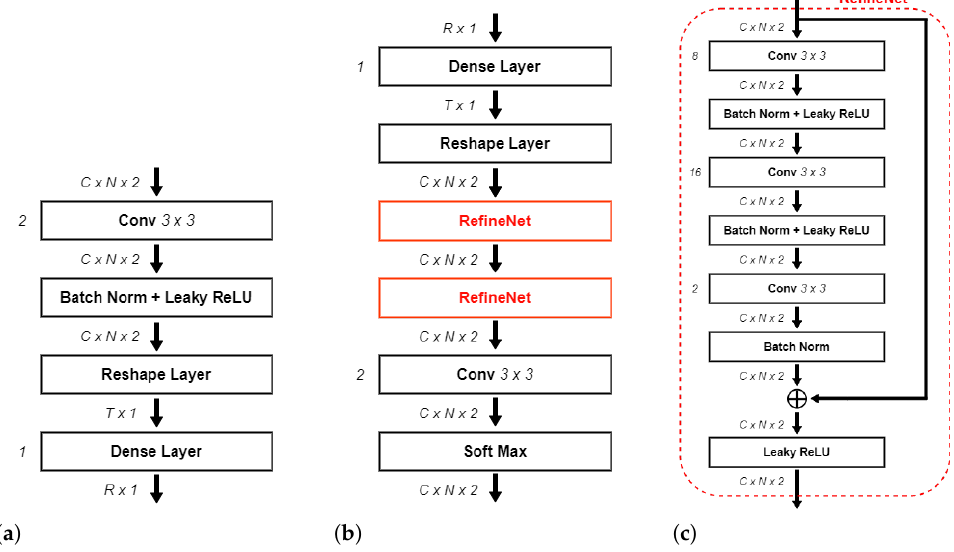
Figure 5. NR-CsiNet representation. ( a ) Block scheme of the NR-CsiNet encoder. ( b ) Block scheme of the NR-CsiNet decoder. ( c ) Block scheme of the RefineNet